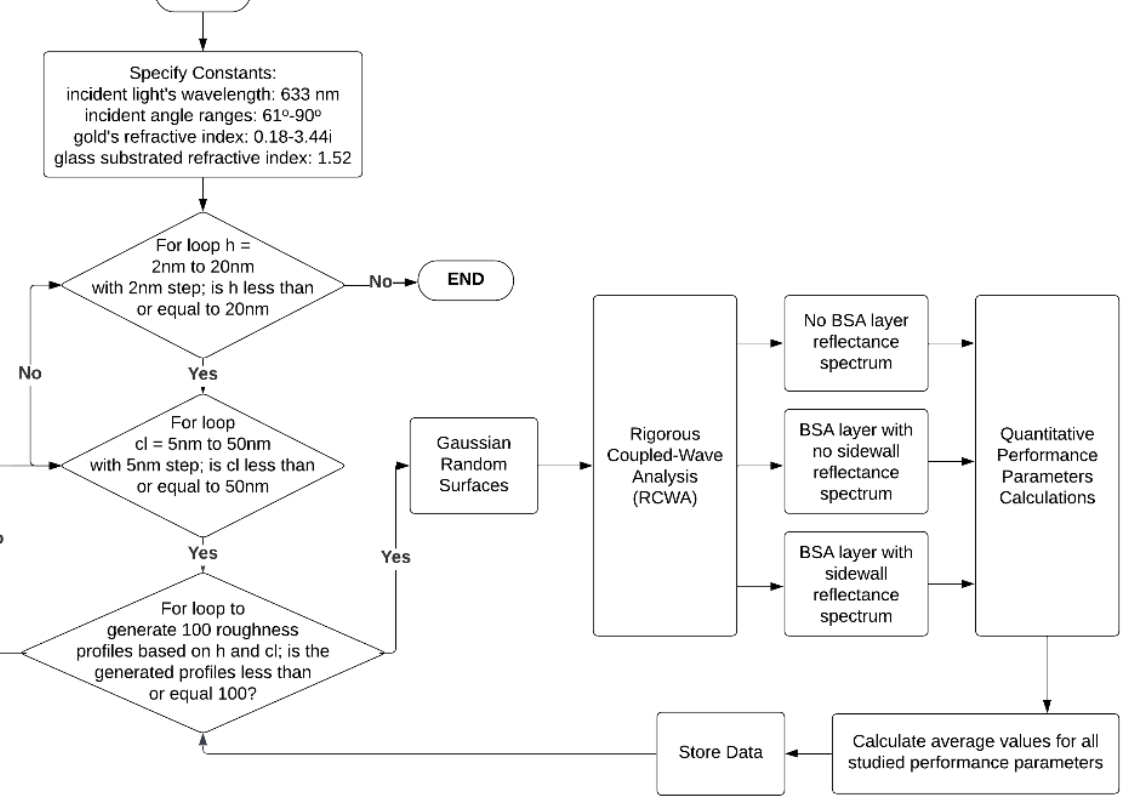
Figure 4. The flowchart of the overall simulation processes, including the rigorous coupled-wave analysis simulation, Monte Carlo simulation, and the performance parameters calculation.